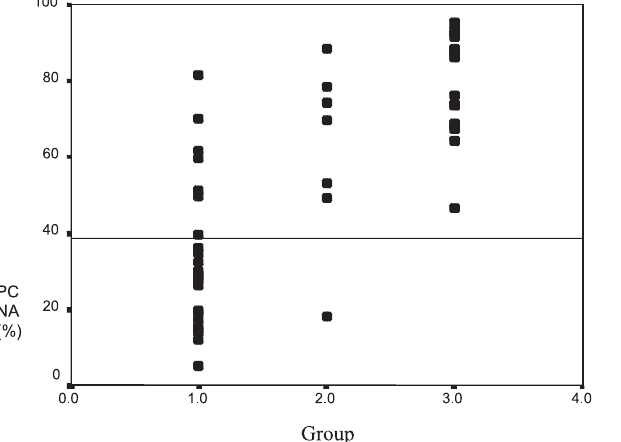
Figure 12 - Kaplan-Meier test for event recurrence, comparing p53 immunoexpression positive and negative